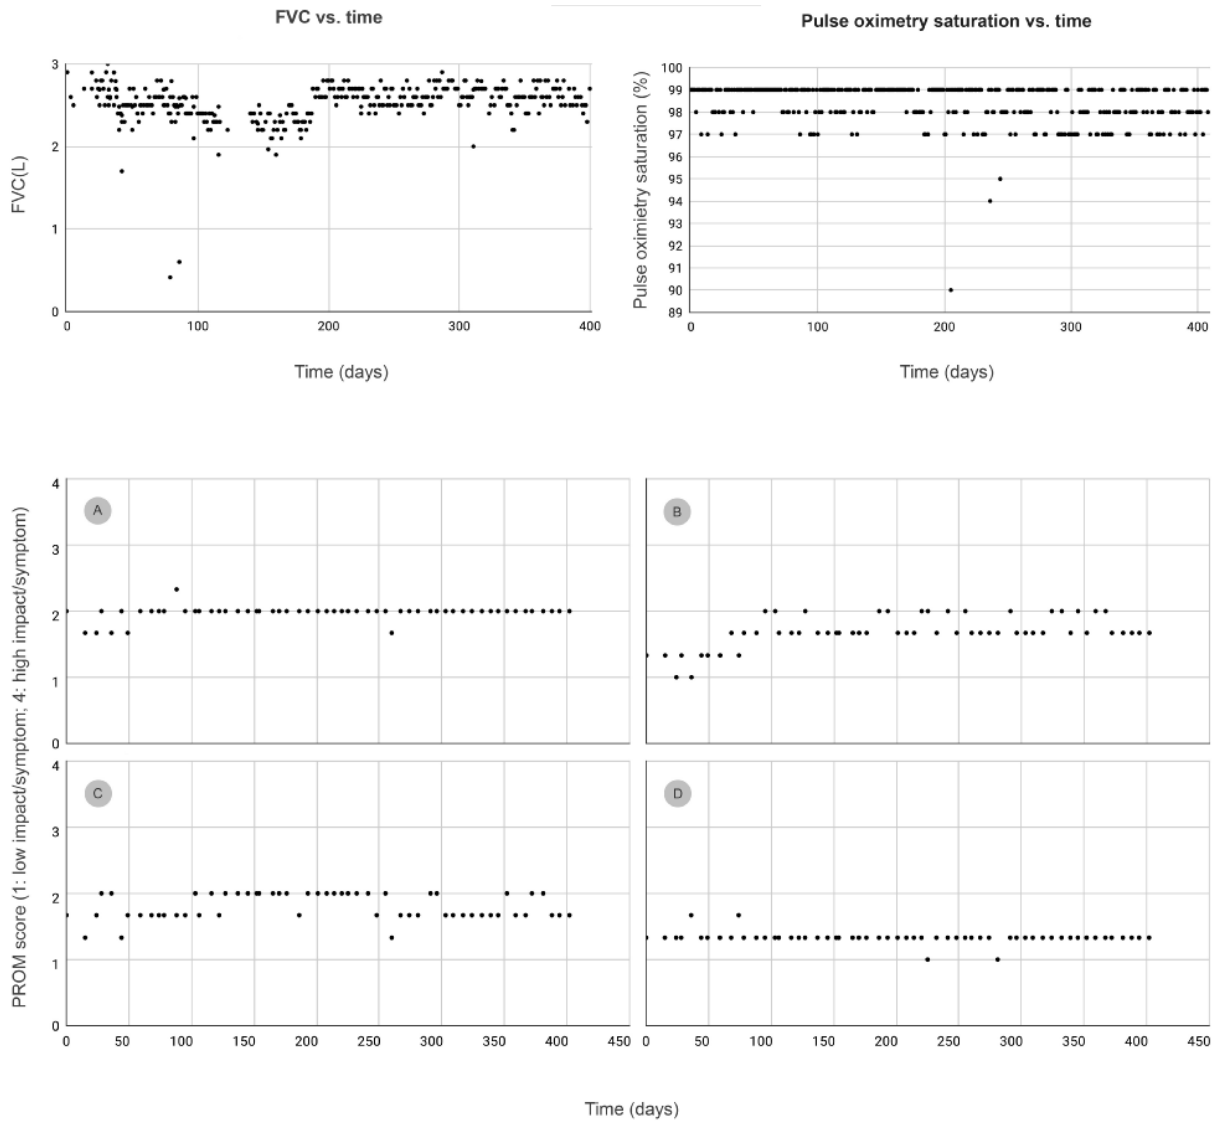
Figure 2. Patient-recorded spirometry, oximetry, and PROM in a single participant over 1 year in 4 domains (A) psychological impact of breathlessness, (B) psychological well-being, (C) physical impact of breathlessness, and (D) fatigue. FVC: forced vital capacity; PROM: patient-reported outcome